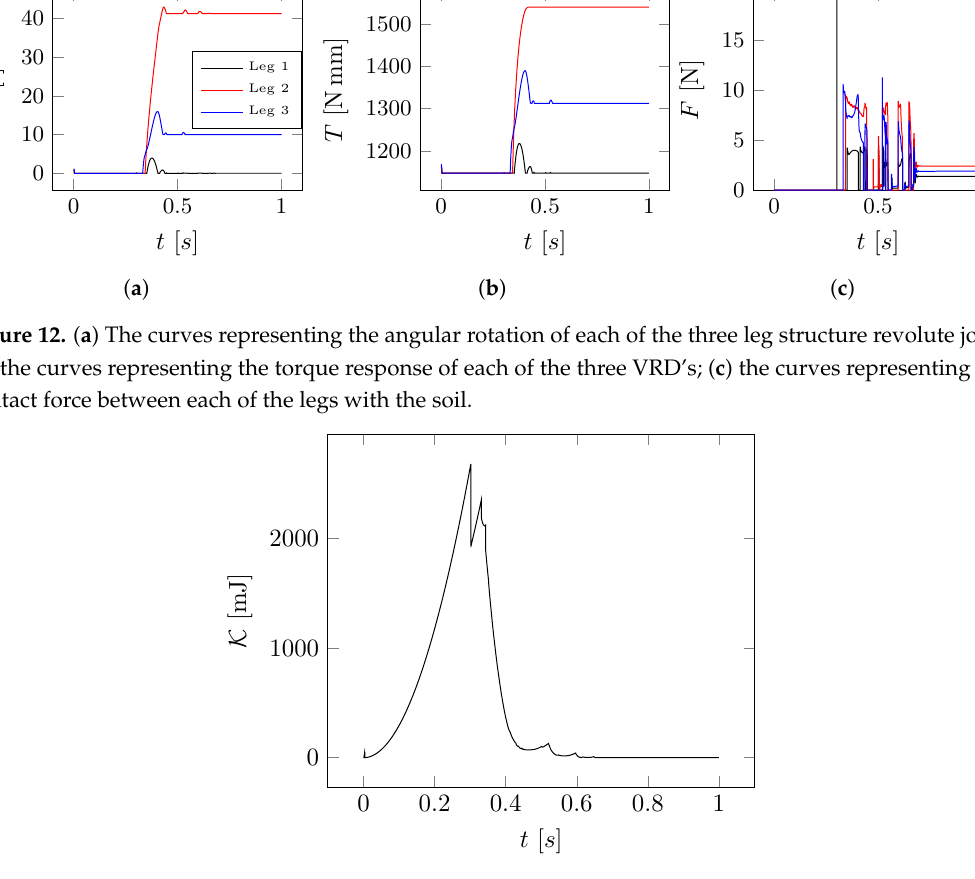
Figure 13. Kinetic energy evolution over time of the lander